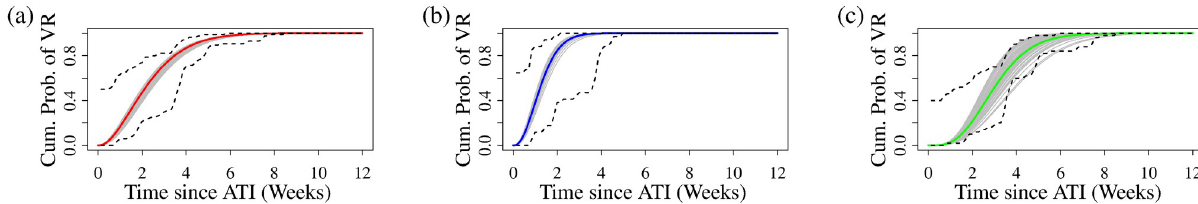
Fig 5. Model predictions on time to viral rebound (VR). Model predictions on time to VR for each ATI study participant (thin grey line) and the average time to viral rebound (thick, solid line), for (a) parameters estimated across all participants while neglecting pre-ATI ART regimen, and participants whose pre-ATI regimen (b) excluded or (c) included NNRTIs. The black, dashed curves give the empirical distributions of the time of last undetectable viral load test and first detectable viral load test.